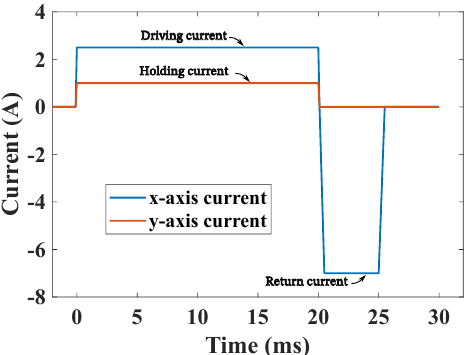
Figure 7. Representation of the current signals used during experimentation.